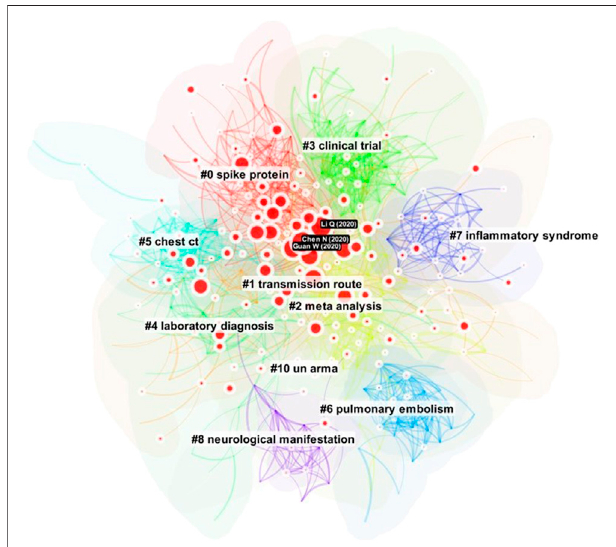
FIGURE 6 | An overview of a smaller network to illustrate SVA. The size of a disc in red depicts epistemic uncertainty (E). The largest three discs are labeled with a black background.